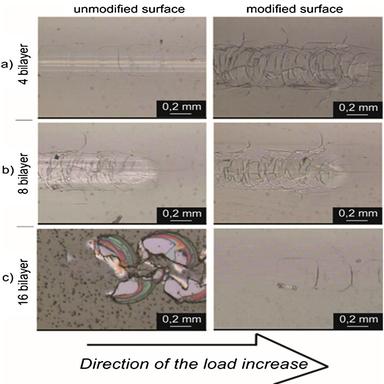
VLM images of scratch tracks of the PTFE + SiO2/silicone multilayer coating on the PEEK substrate with different numbers of interlayers with and without an additional silicone top layer after the scratch tests: a) image of the scratch track of the 4-bilayer coating; b). image of the scratch track of the 8-bilayer coating; and c). image of the scratch track of the 16-bilayer coating.